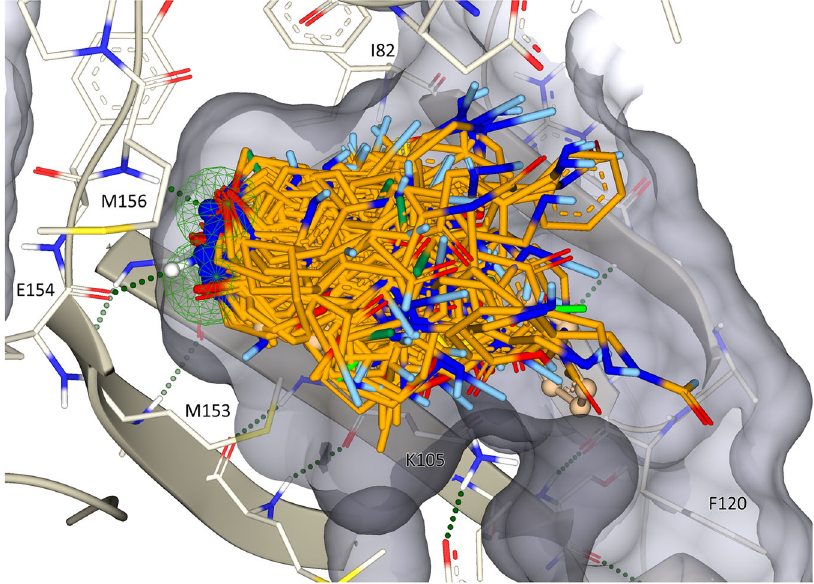
Fig.1|Dockedposesofselectedstartingfragmentposes. Arepresentativesetof docked poses (80 of the 500 initial fragments) are shown in the ROCK1 binding site. The binding pocket surface is shown in gray, and the hinge-binding